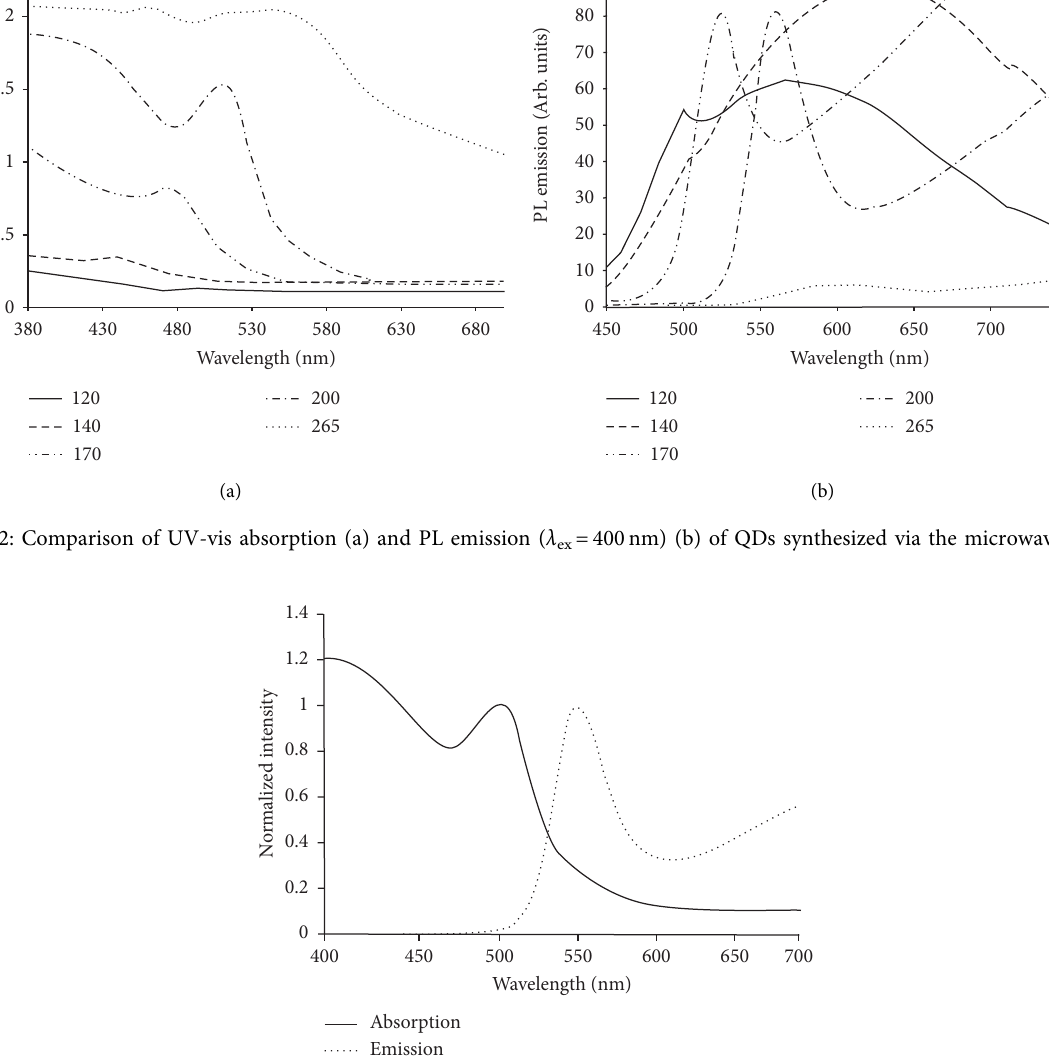
Figure 3: Example of Stokes shift of QDs (200 ° C; hold time, 2min 30s), showing that absorption (solid line) occurs at a higher energy than emission (dotted line) via photoexcitation at